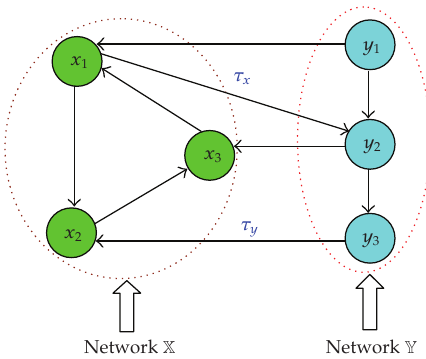
Figure 1: A simple action sketch between two coupled networks with time